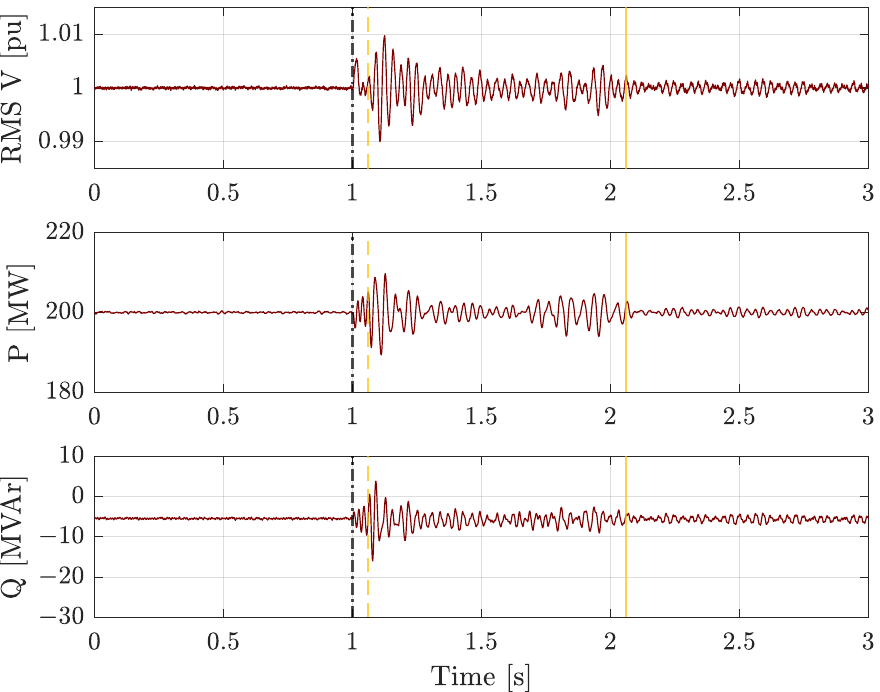
Figure 7. RMS voltage, real power, and reactive power waveforms when output power exceeds 1.050 pu. (black dashed line is when Line #2 trips, yellow dashed line is when SSCI is detected, and yellow straight line is when a stable operating point is found).